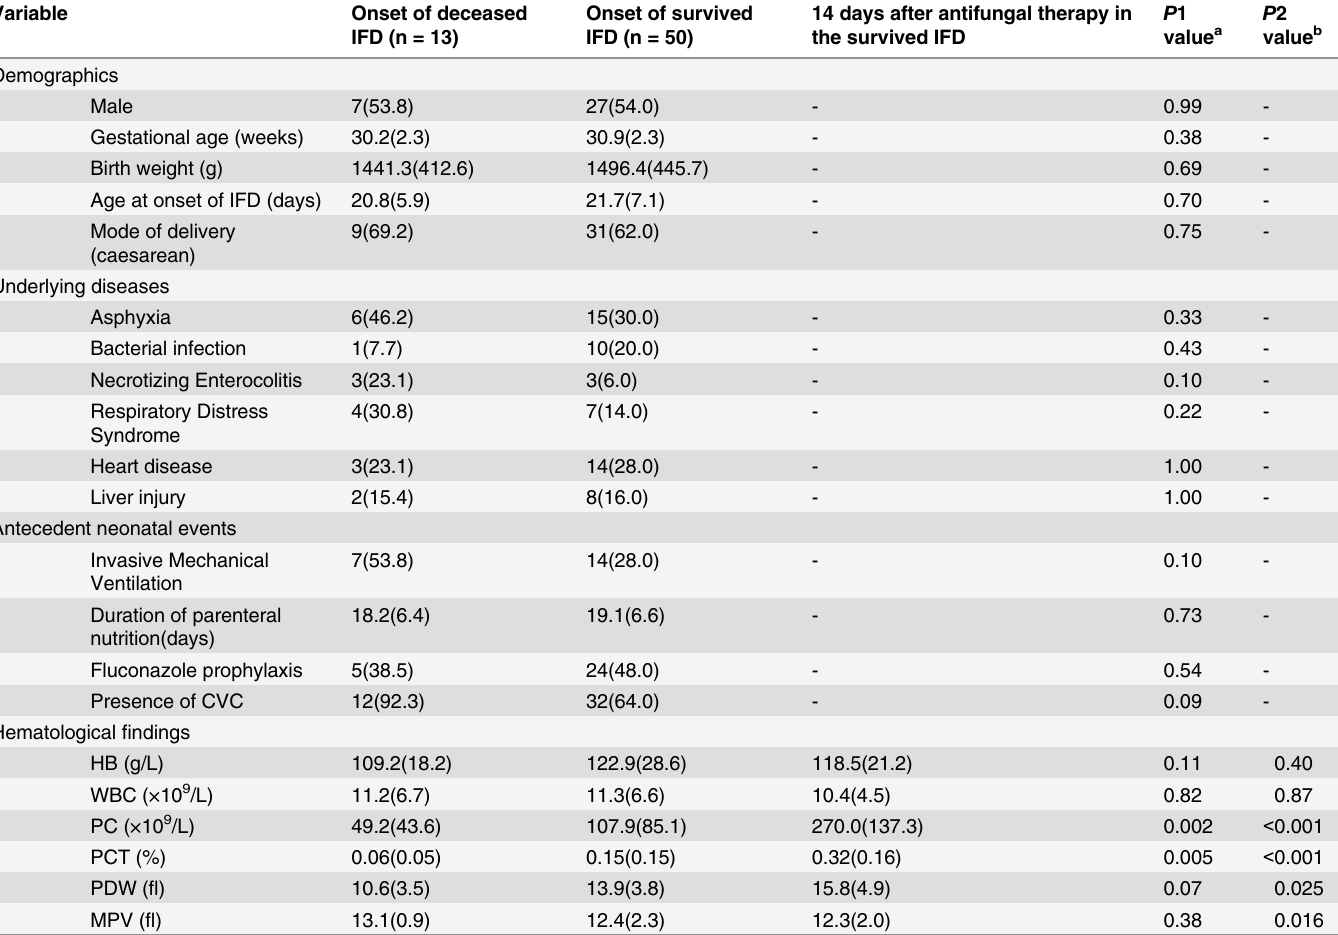
Table 4. Birth, clinical characteristics and hematological findings in deceased versus survived IFD at the onset and 14 days after antifungal thera- py in survived IFD infants. Variable Onset of deceased Onset of survived IFD (n = 13) IFD (n =